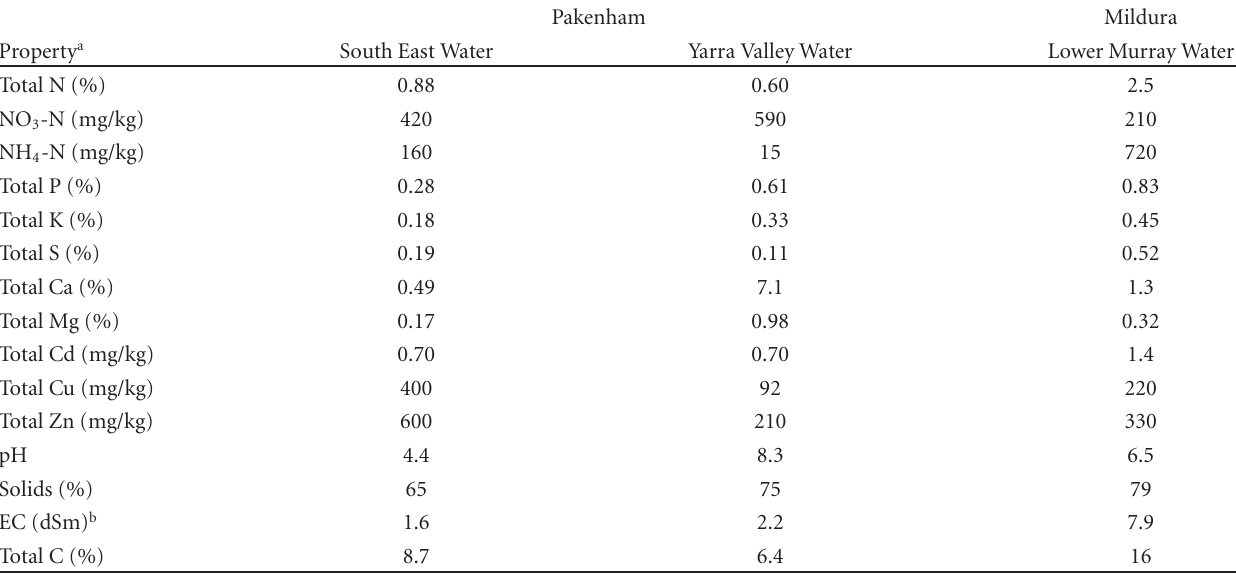
Table 2: Properties of biosolids applied to pasture and grape vines in the National Biosolids Research Program, Victoria.